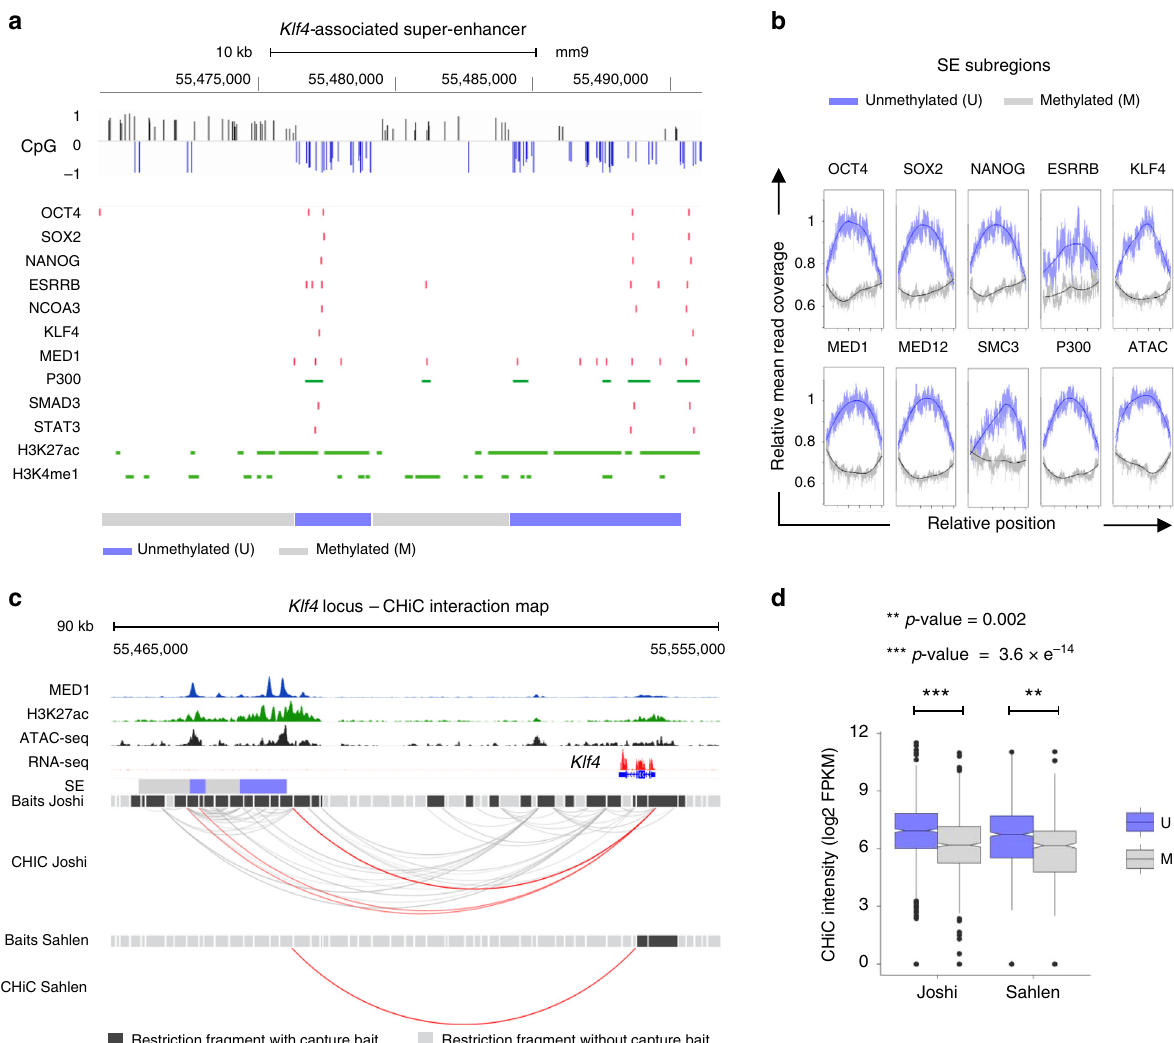
Fig. 1 Demarcation of active enhancer units within SEs through CpG methylation pro fi ling in ESCs. a Schematic representation of the Klf4 -associated SE in embryonic stem cells (ESCs) grown in serum/LIF, showing CpG methylation, TF binding sites and epigenetic marks along the SE locus. The methylation state of each CpG was determined using a HMM: unmethylated = blue, down; methylated = grey, up. In addition, the height of the bars indicates the extend of methylation (positive values) and demethylation (negative values) of each CpG (see also Methods section). Coordinates of the Klf4 -associated SE are shown as reported in ref. 8 . b Mean Chip-seq read coverage of TFs, mediator and cohesin subunits, P300 and ATAC-seq signals at unmethylated (U; blue) and methylated (M; grey) SE subregions in ESCs (serum/LIF). The mean read coverage scores were scaled to the maximal value for either region set. Publicly available datasets used are listed in Supplementary Data 1. c Promoter – SE interactions along the Klf4 locus. The capture baits (black) for the Joshi et al. 15 and Sahlen et al. 16 capture Hi – C interactions are shown. Key epigenetic enhancer marks (MED1, H3K27ac and ATAC-seq) overlap with unmethylated SE subregions (U; blue) across Klf4 -associated SE, while methylated regions (M; grey) are largely devoid of active histone marks. Promoter – SE and intra-SE interactions are shown as red arcs; other interactions as grey arcs. d Box plots of the capture Hi – C interaction intensity (log2 fragments per kilobase million (FPKM)) of unmethylated (U; blue) and methylated (M; grey) SE subregions for which the SE has a signi fi cant interaction with the target promoter. For this analysis, only expressed SE-interacting gene promoters were considered (reads per kilobase million (RPKM) ≥ 1). Unmethylated SE subregions interact at a signi fi cantly higher frequency as compared to methylated SE subregions with an equal number of capture baits (** p = 0.002; *** p = 3.6 × 10 − 14 , analysis of variance, controlling for the number of capture Hi – C baits per SE subregion and the log2 promoter – SE subregion